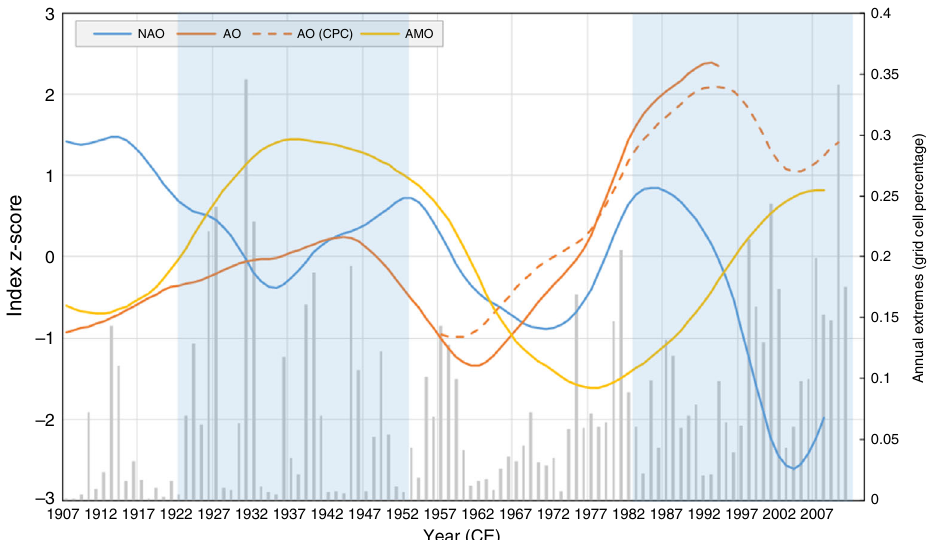
Fig. 8 Annual pluvial extremes and major atmospheric/oceanic circulation indices. 30-year low-pass fi lter (loess) z -scores of annual North Atlantic Oscillation (NAO), Arctic Oscillation (AO, AO-CPC) and Atlantic Multidecadal Oscillation (AMO). All datasets extracted from the KNMI explorer online platform. Light blue shade represents the intervals 1923 – 1952 and 1983 – 2012. On the secondary vertical axis, the grid cell percentage of annual extremes (above the 0.95 quantile) is presented for comparison purposes (grey bars). The periods of spatial polarization are highlighted by transparent blue